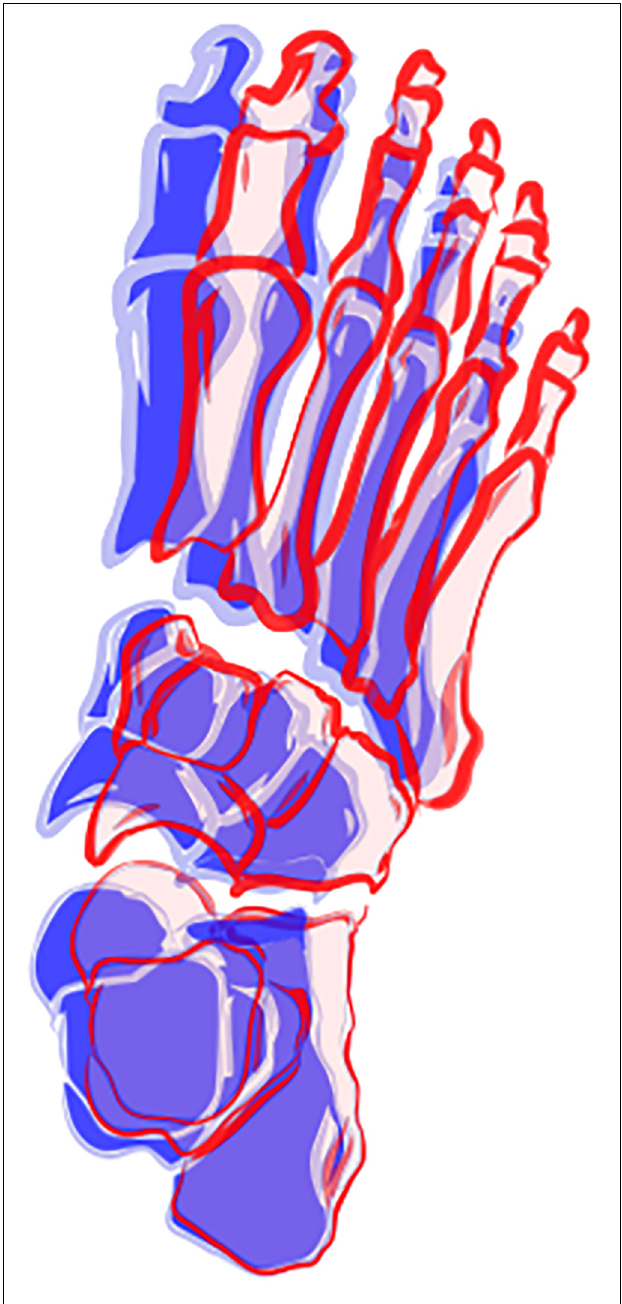
FIGURE 6 | Illustration of between-cluster differences of foot and ankle movement patterns in the transverse plane. The average pattern for cluster 1 is represented in red and for cluster 2 is represented in blue.